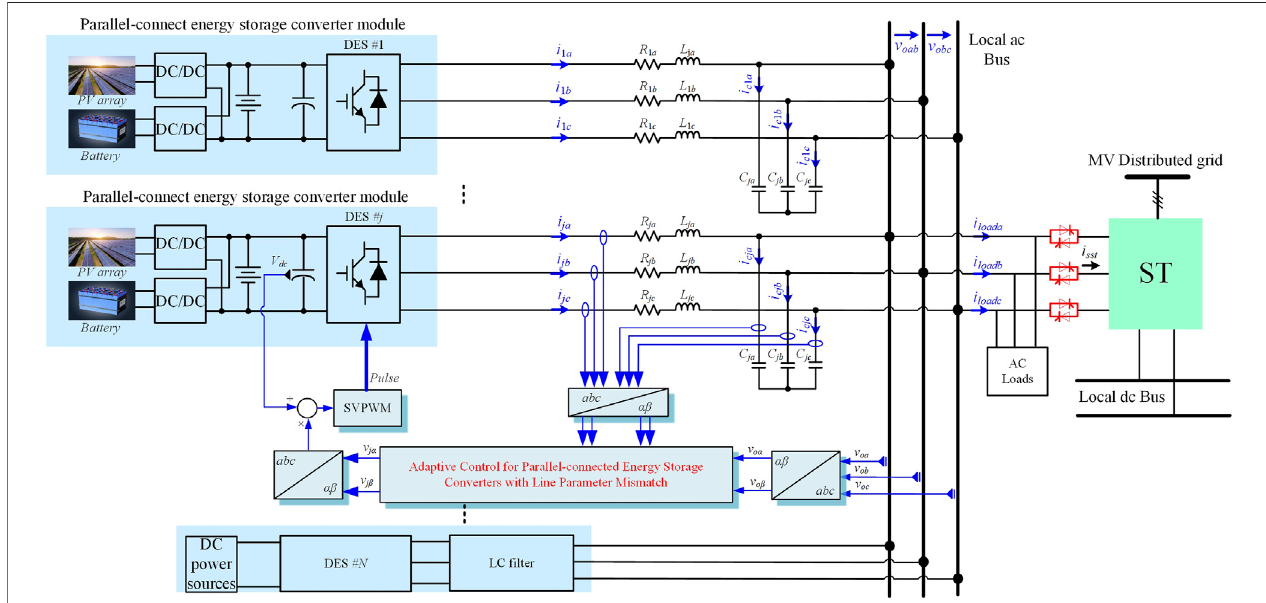
FIGURE 2 | The simpli fi ed con fi guration of a ST enabled parallel-connected DES based microgrid.